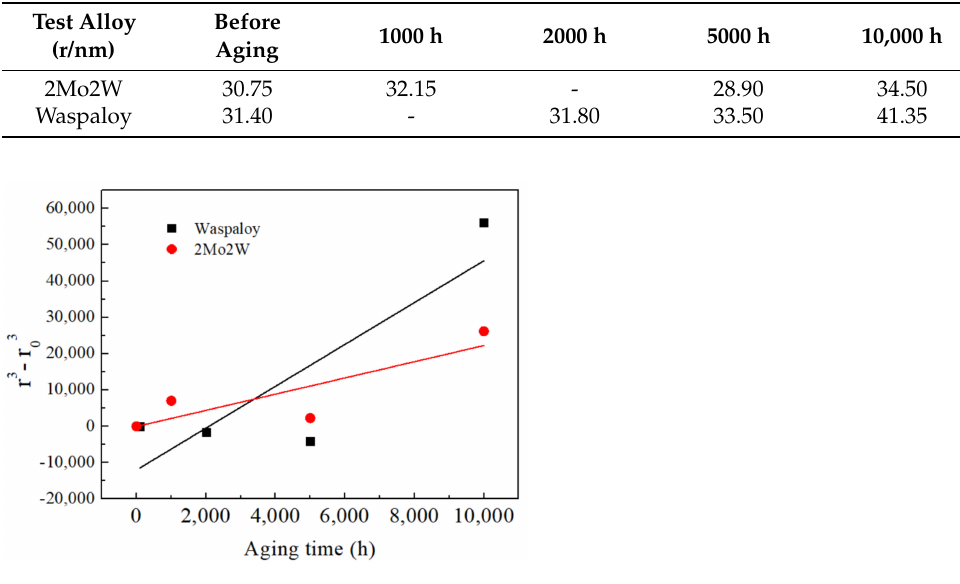
Figure 7. Coarsening rates of 2Mo2W alloy and Waspaloy during long-term aging at 700 ◦ C.